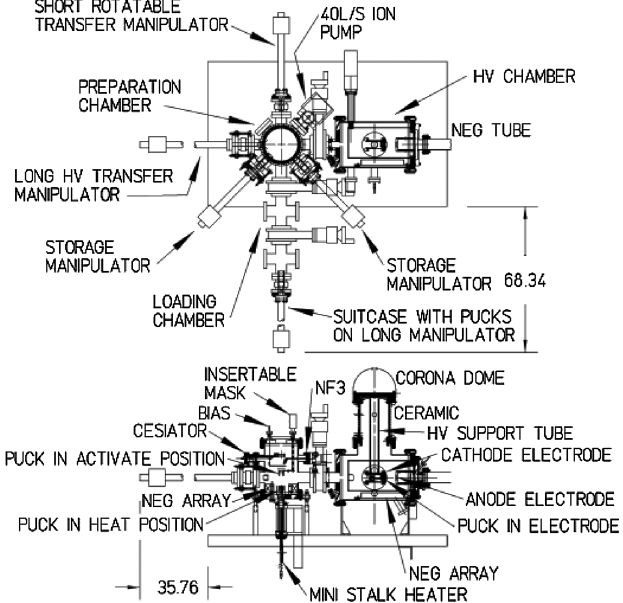
FIG. 3. (Top) Plan view shows the complete gun assembly with four vacuum chambers: gun high voltage chamber (large-bore ceramic insulator design), preparation chamber, intermediary chamber, and Suitcase. (Bottom) Side view shows some of the components inside the preparation chamber including a heater that also serves to move the puck toward a mask used to selectively activate only the center portion of the